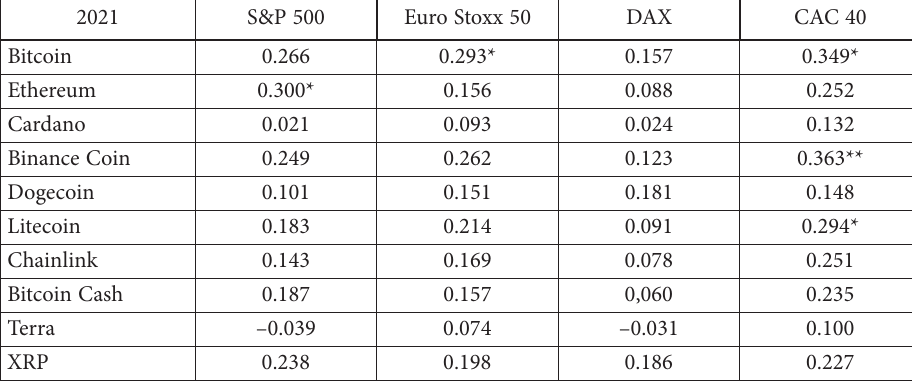
Table 6. Correlation (source: compiled by the